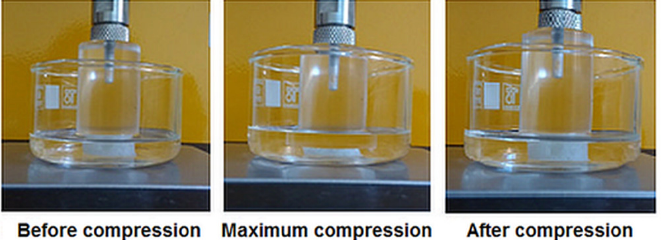
Figure 4. Real ‐ time imaging of sample cryogel CP7 (Entry 2, Table 1) during the compression test.